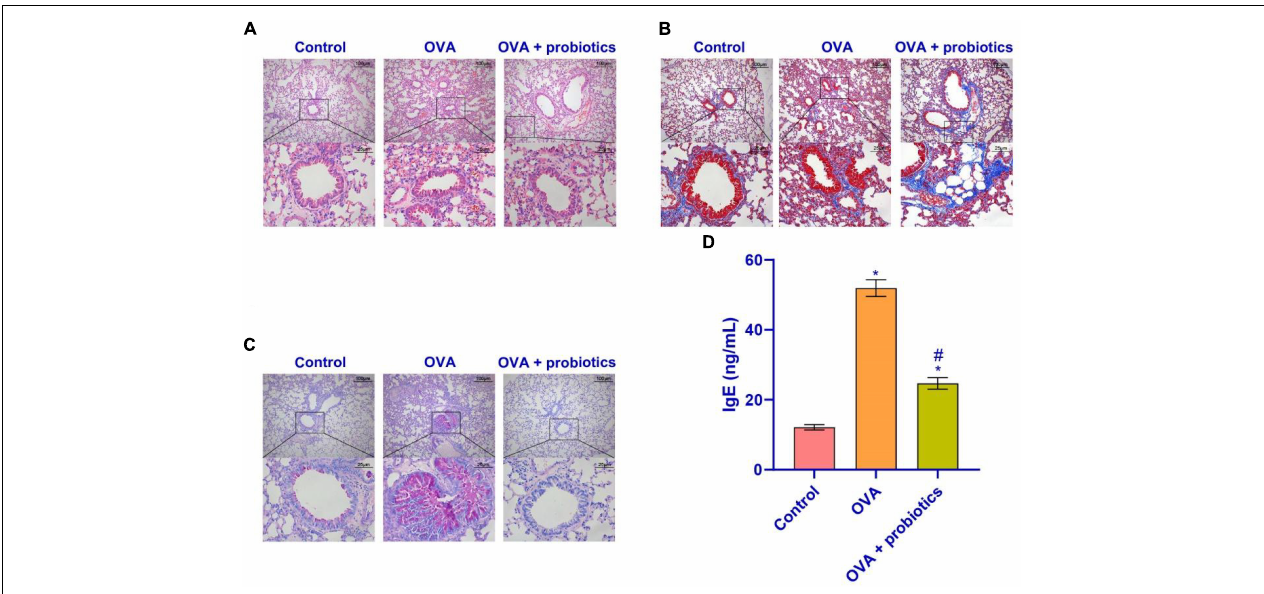
FIGURE 6 | Lactobacillus fermentum CECT5716 could relieve the inflammatory cell infiltration. (A) HE staining was performed to determine the pathological changes in the lung tissue. (B) The degree of lung fibrosis was analyzed by Masson staining. (C) PAS staining was utilized to observe the proliferation of tracheal goblet cells in the lung tissues of each group. (D) Level of IgE in the serum. Up: × 100, scale bar = 100 µ m; down: × 400, scale bar = 25 µ m. *Compared with the control group, P < 0.05. # Compared with the OVA group, P < 0.05. One-way ANOVA was used among multiple groups. n = 5 for each